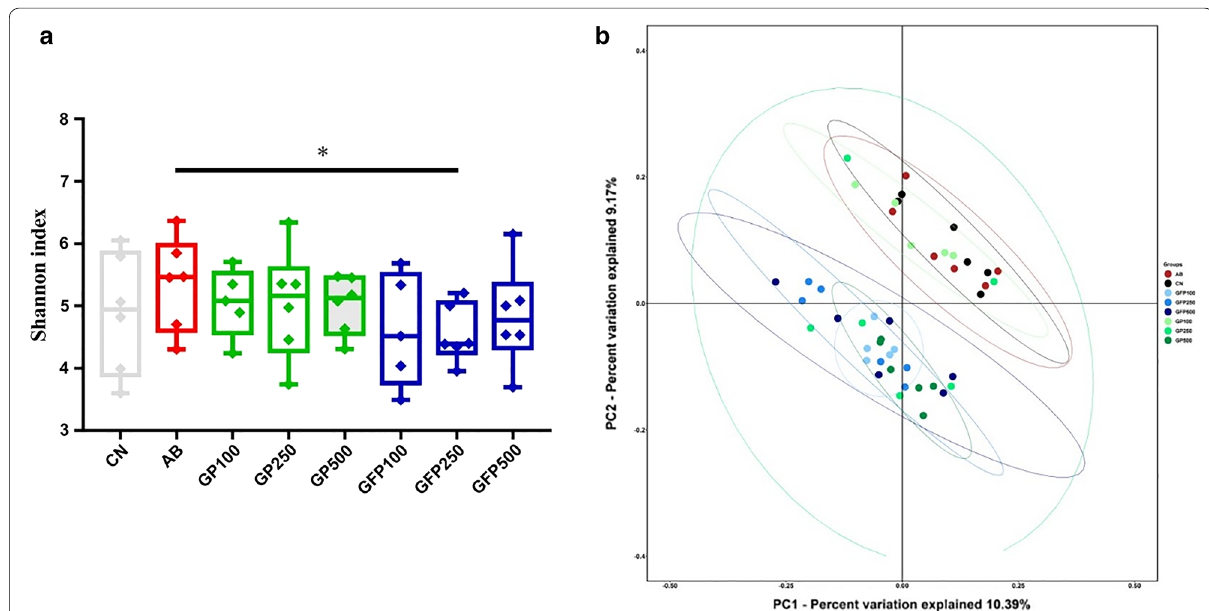
Fig. 3 Microbial diversity in intestinal contents after supplementation with different doses of XOS in pigs at different stages of development. a Shannon index. b Scatterplot of unweighted UniFrac distance matrix Principal coordinates analysis. * P <